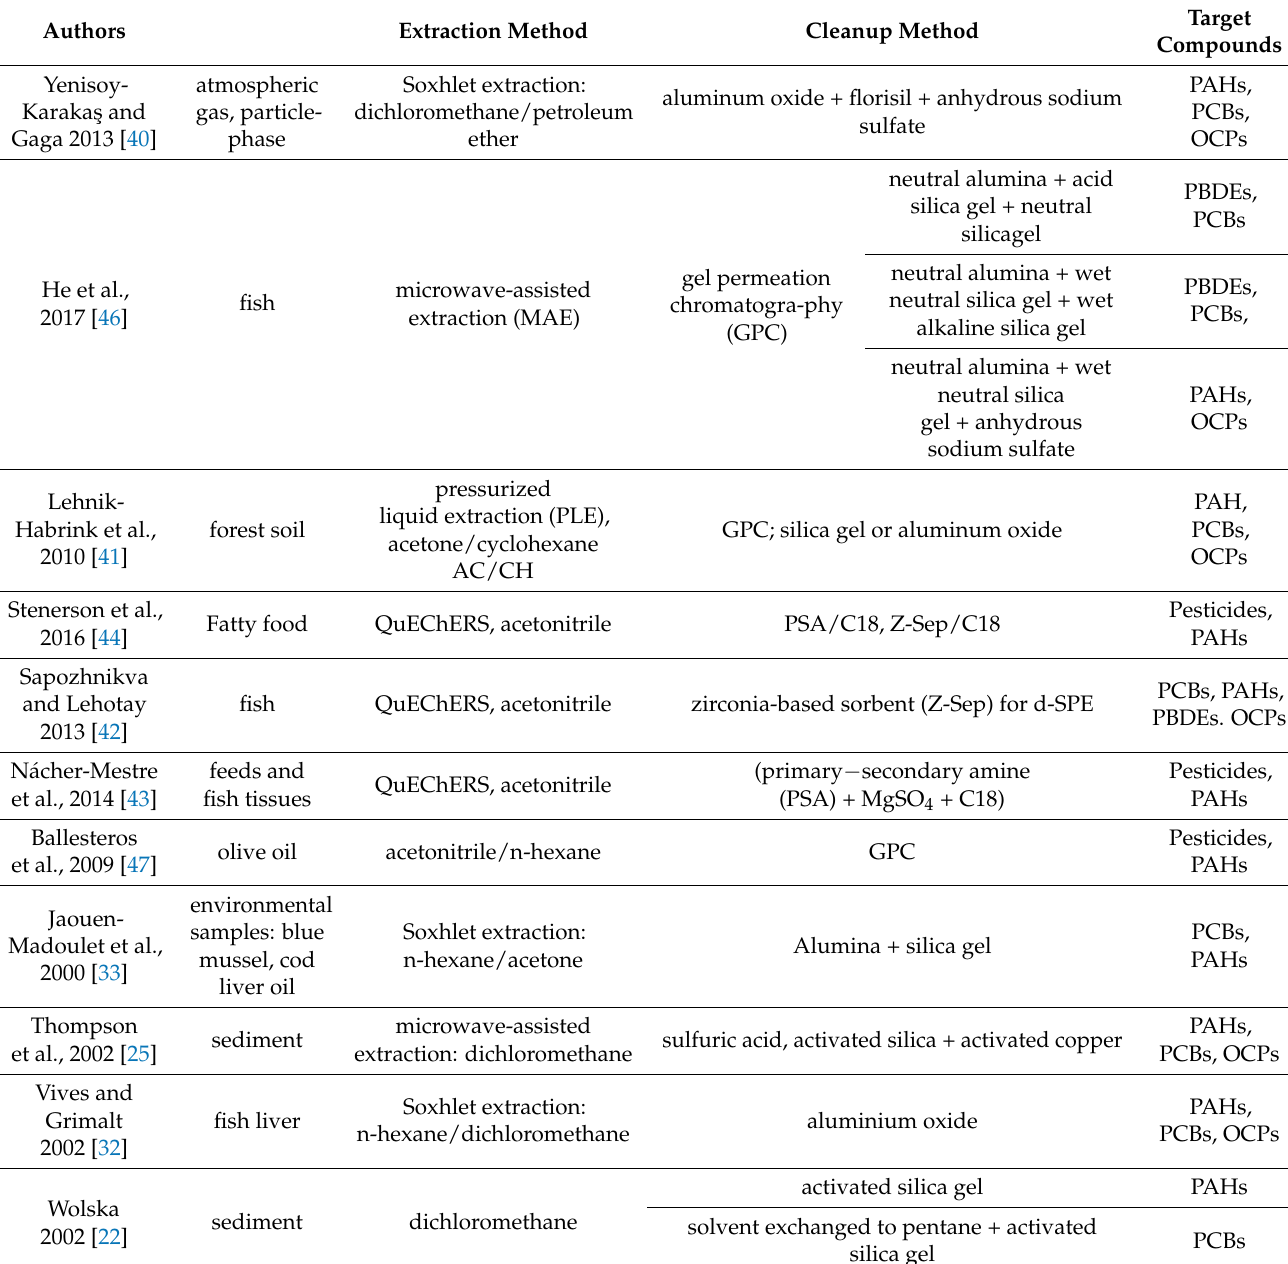
Table 5. Comparison of methods for preparing samples for determinations of PCBs and